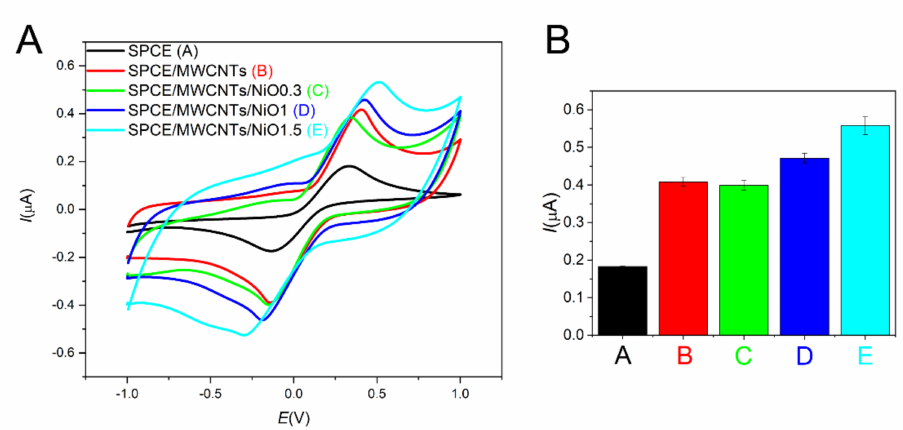
Figure 6. Cyclic voltammograms for different modifications of the screen-printed electrode ( A ) (SPCE—black curve A , SPCE/MWCNT—red curve B , SPCE/MWCNT/NiO0.3—green curve C , SPCE/MWCNT/NiO1—blue curve D , SPCE/MWCNT/NiO1.5—turquoise curve E ) in 5 mM K 3 [Fe(CN) 6 ]. Comparison of the current response for the par- ticular electrode modifications ( B